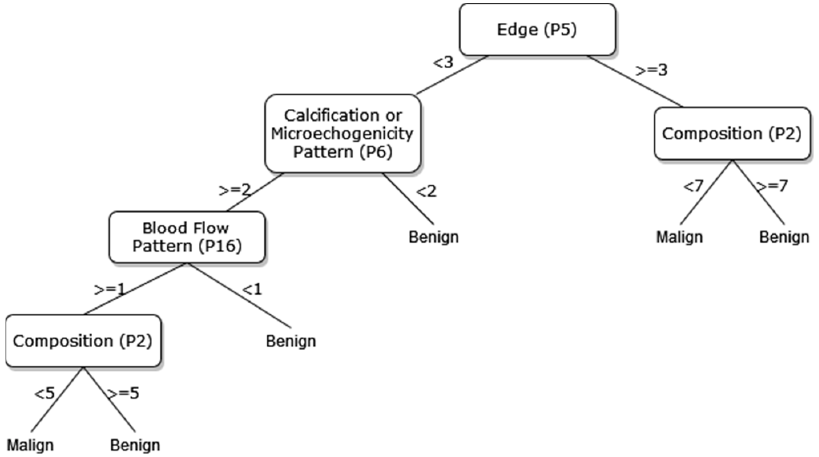
Figure 8. The pruned DT of 27 sonographic signs.